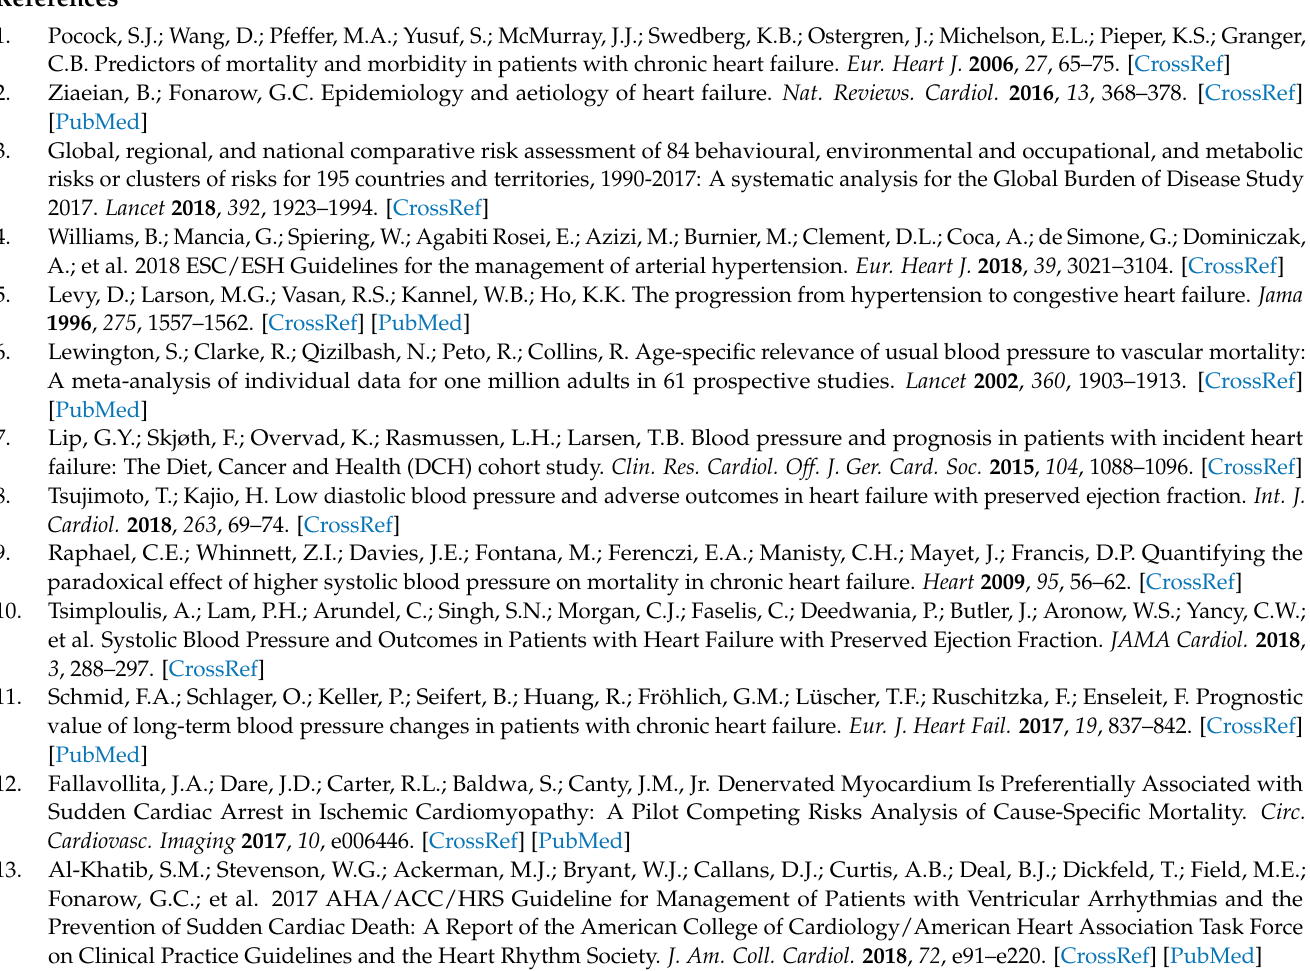
Figure S3. Restricted Cubic Spline Plots for Primary Outcome by Diastolic Blood